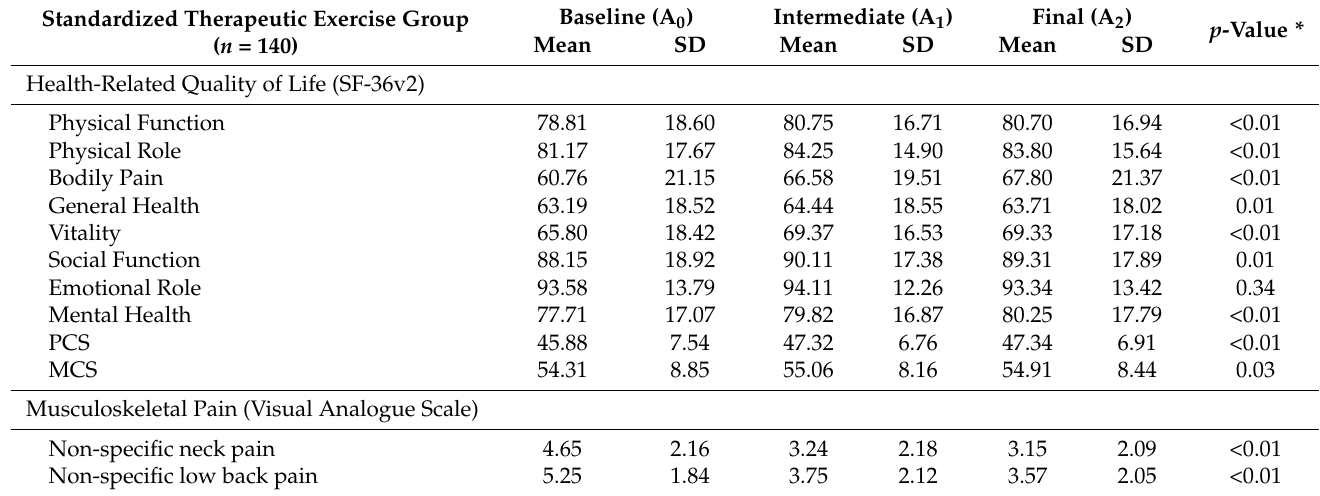
Table 5. Standardized Therapeutic Exercise Group at baseline (A 0 ), post-intervention (A 1 ), and final (A 2 )